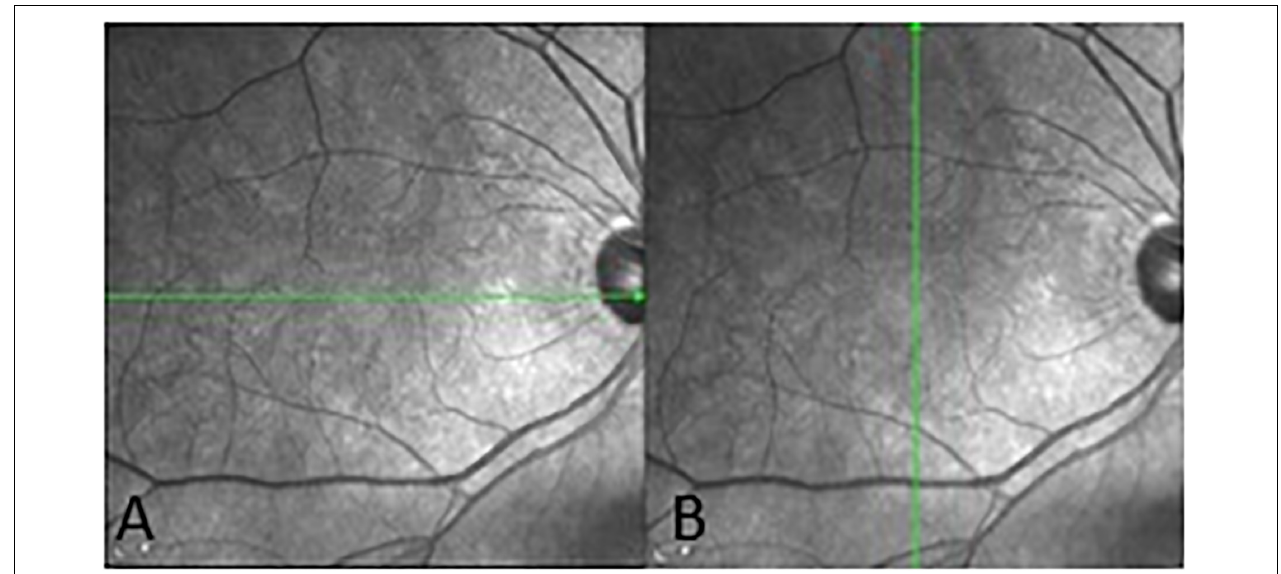
FIGURE 1 | Cross-sectional (A) and longitudinal (B) choroidal images from SD-OCT.